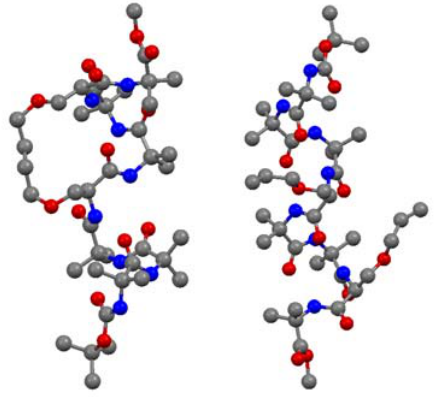
Figure 13. X-ray crystal structures of a 3 by RCM. Hydrogen atoms have been omitted for